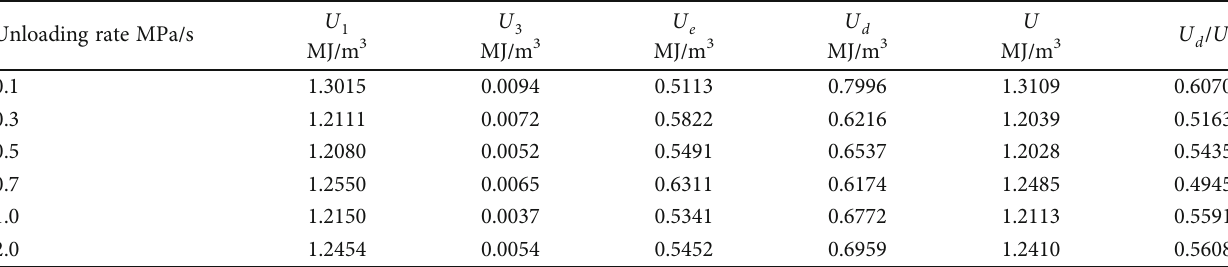
Table 4: Strain energy density at the unloading